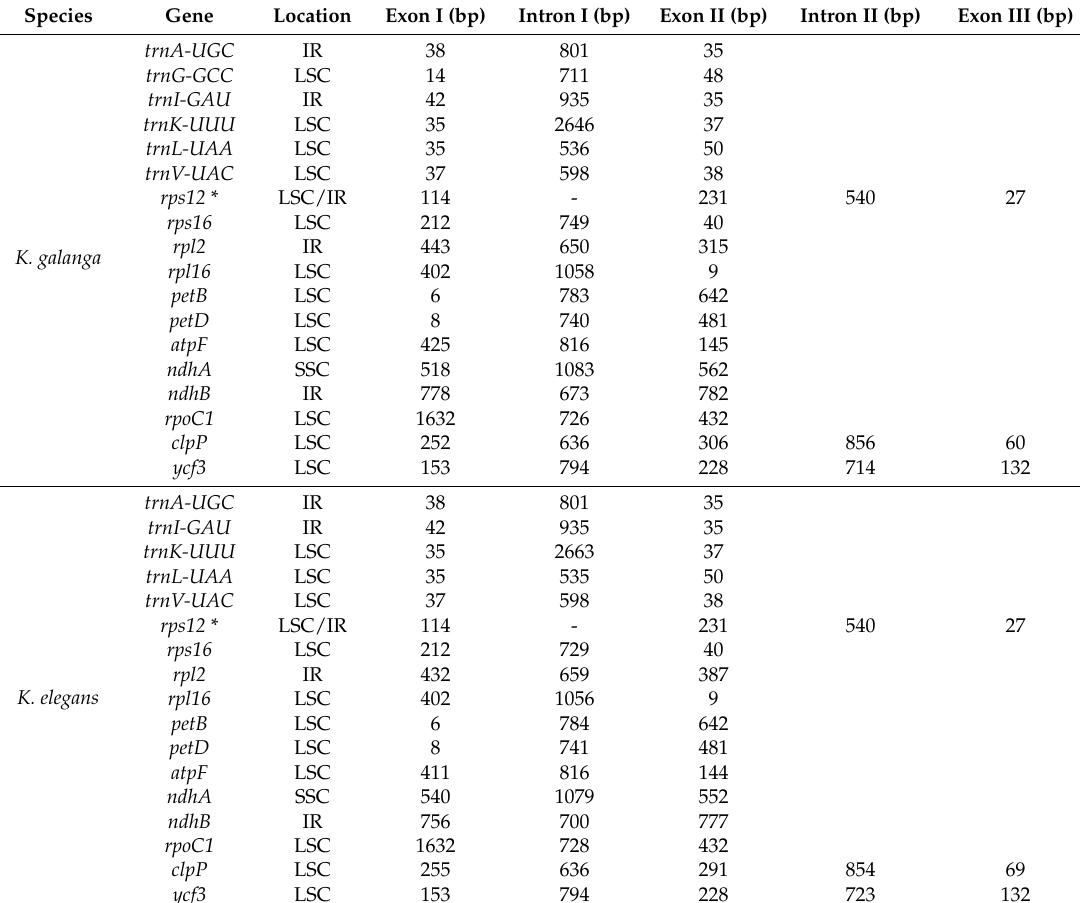
Table 3. Genes with introns in the chloroplast genomes of K. galanga and K. elegans , including the exon and intron